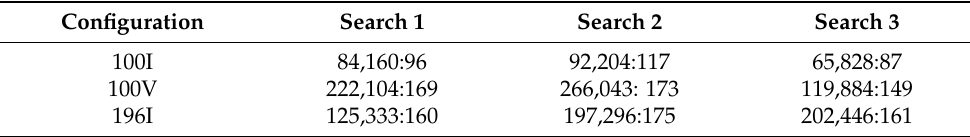
Table 1. Computational cost of the each optimization search line (apertures evaluated: candidate apertures).